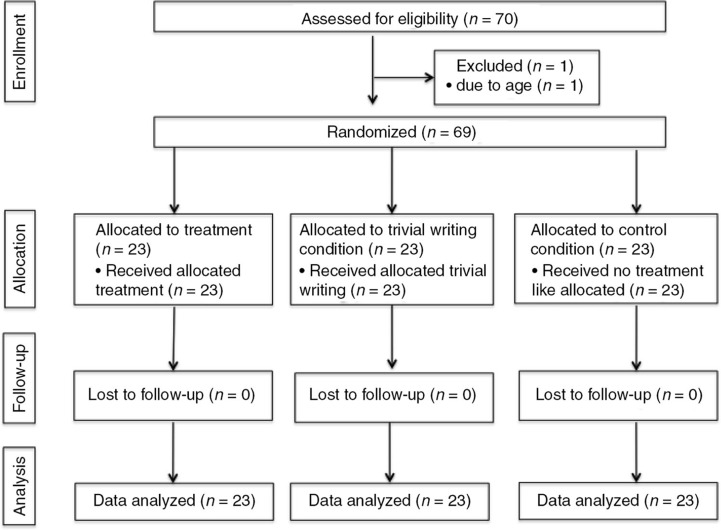
Participant flow.